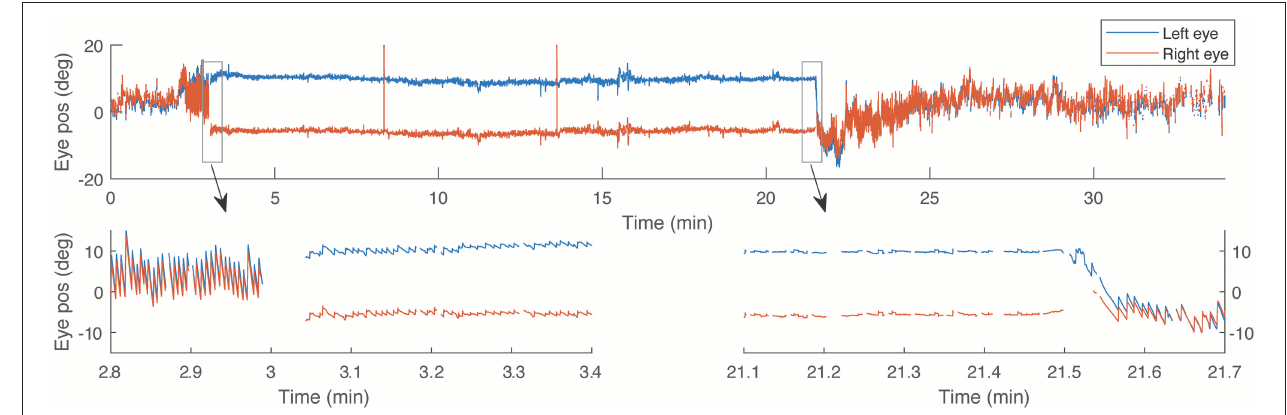
FIGURE 1 | An example recording of horizontal eye position during a 20-min trial with visual fixation. Bottom panels show details of 30-s time periods around the times when the light turns on and off, respectively. Gaps in the data correspond with eye blinks.